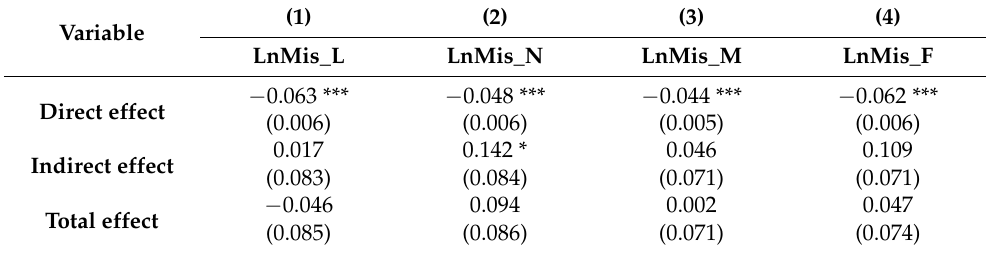
Table 10. Effect decomposition